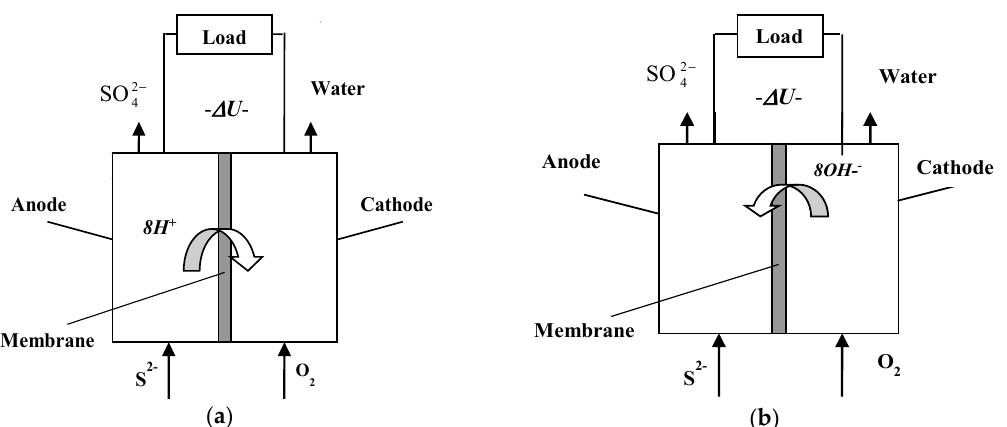
Figure 1. Working principle of a sulfide-driven fuel cell associated with proton ( a ) and OH − ( b ) exchange across the membrane.